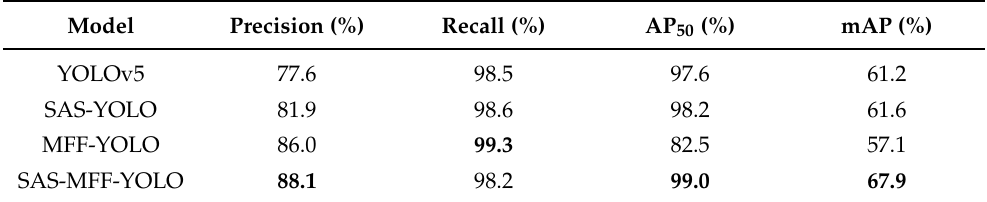
Table 3. The performance of different models on the dataset provided by AI Research Institute. Precision and recall are for pneumonia classification, while AP 50 and mAP are for the task of lesion object detection.